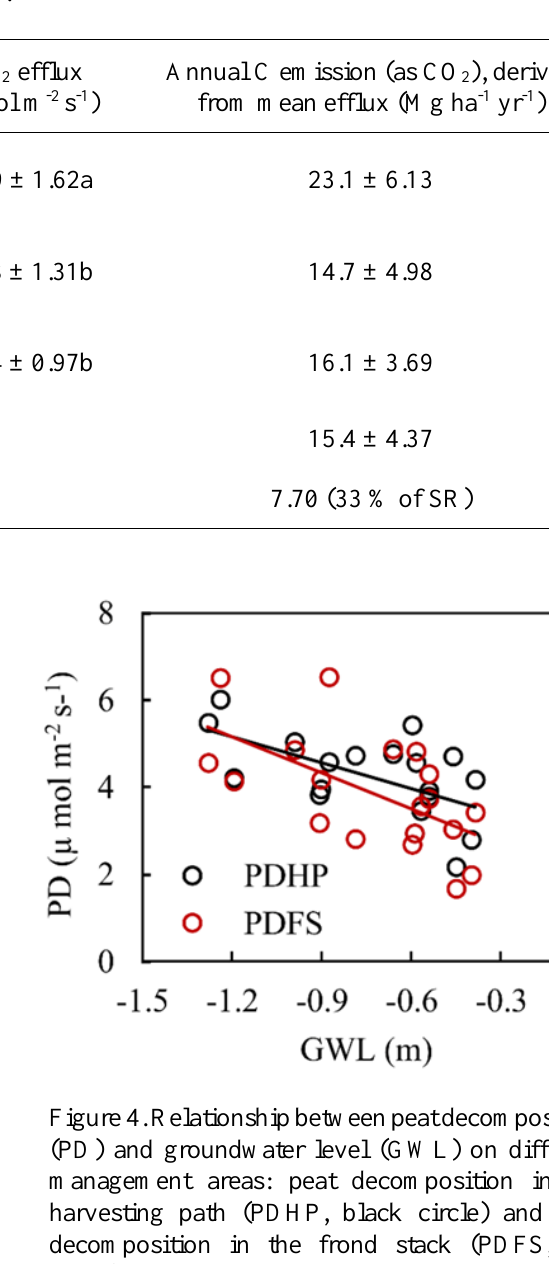
Table 2. Mean soil CO 2 efflux at different management areas (mean ± SD; n = 3) from September 2018 to March 2020. Different letters denote significant difference ( P < 0.05) between management areas (RC, FS, HP) according to Tukey HSD test following ANOVA.